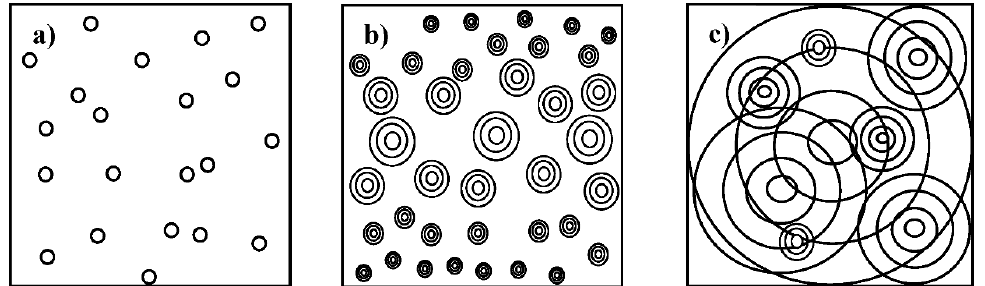
Figure 2. ( a ) In the microscopic model of laminar flows in a channel molecules of a single diameter d are flying about with a mean free path length λ . In Boussinesq’s turbulence closure with a constant eddy viscosity the analogous mechanism occurs, there are moving eddies of only one size. ( b ) On the other hand, in Prandtl’s mixing-length model, where the eddy viscosity is dependent on the mean downstream velocity u 1 ( x 2 ) , the eddy diameter d also depends on the x 2 -coordinate (pointing in the vertical direction to the top) which leads to a stratification of eddies of different sizes ( c ) In a real turbulent flow (roughly sketched in this image) the situation is even more complex: momentum is transferred by a cascade of fractal eddies (for simplicity they are drawn circular with their mean discretized diameters d 0 . . . d N ) and at each location x 2 eddies of many different sizes act simulta- neously.